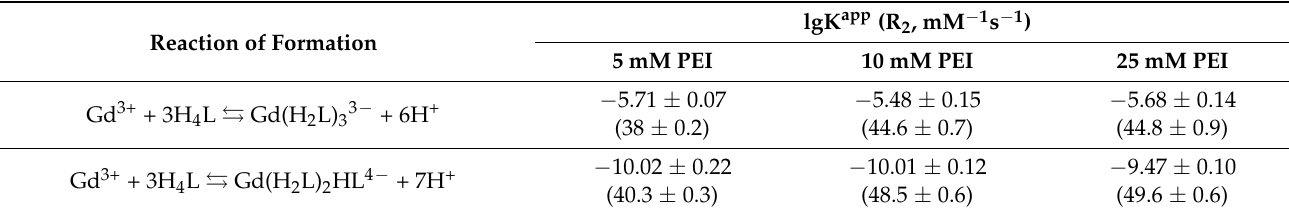
Table 2. Equilibria of the reactions of formation of the complex forms in the gadolinium(III)–citric acid (H 4 L)–PEI0 system, their magnetic-relaxation characteristics, and apparent equilibrium constants (K app